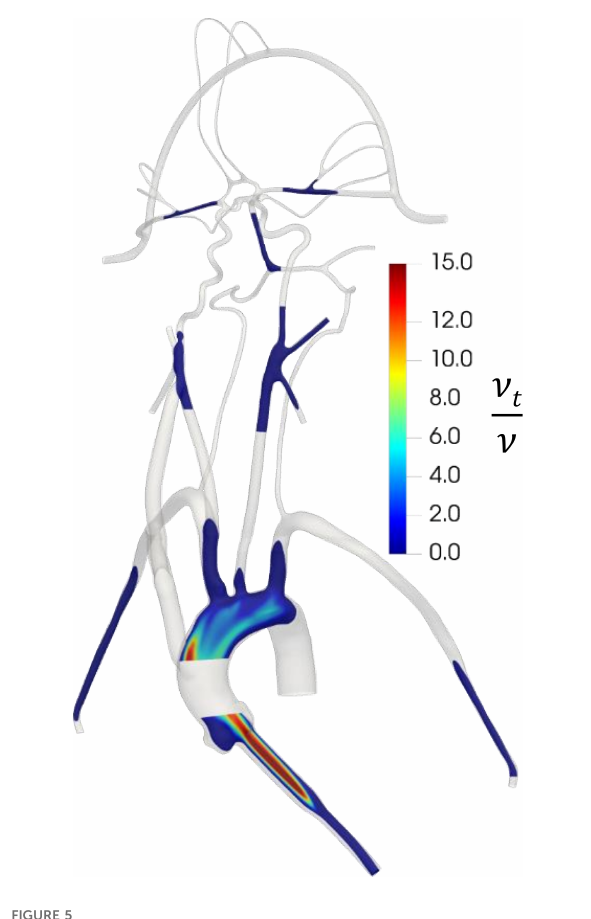
FIGURE 5 Contours of the distribution of the ratio of turbulent viscosity ( n t ) to molecular viscosity ( n ) in the CFD model, illustrating regions of predicted turbulent fl ow where n t = n is large and regions of laminar fl ow where n t = n is